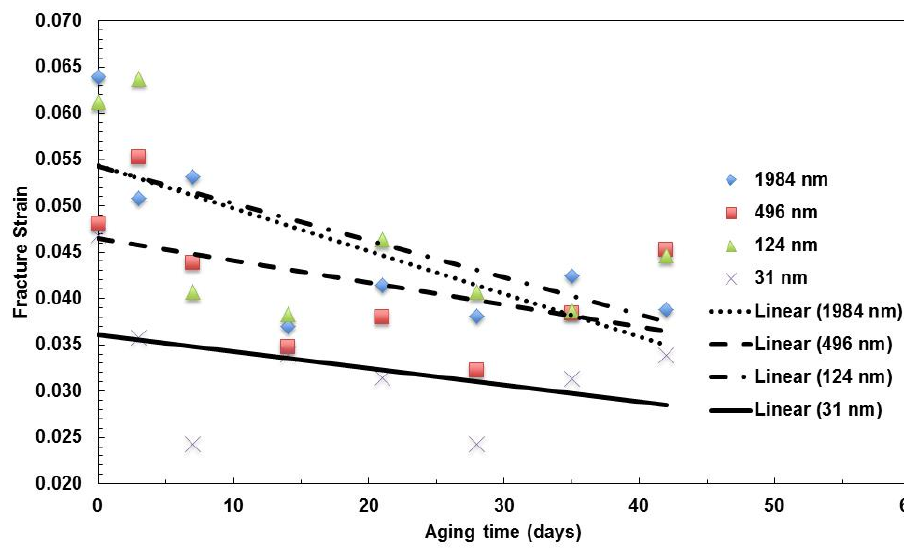
Figure 4. Summary of the change in fracture strain with aging time for films with various layer thicknesses aged at 100